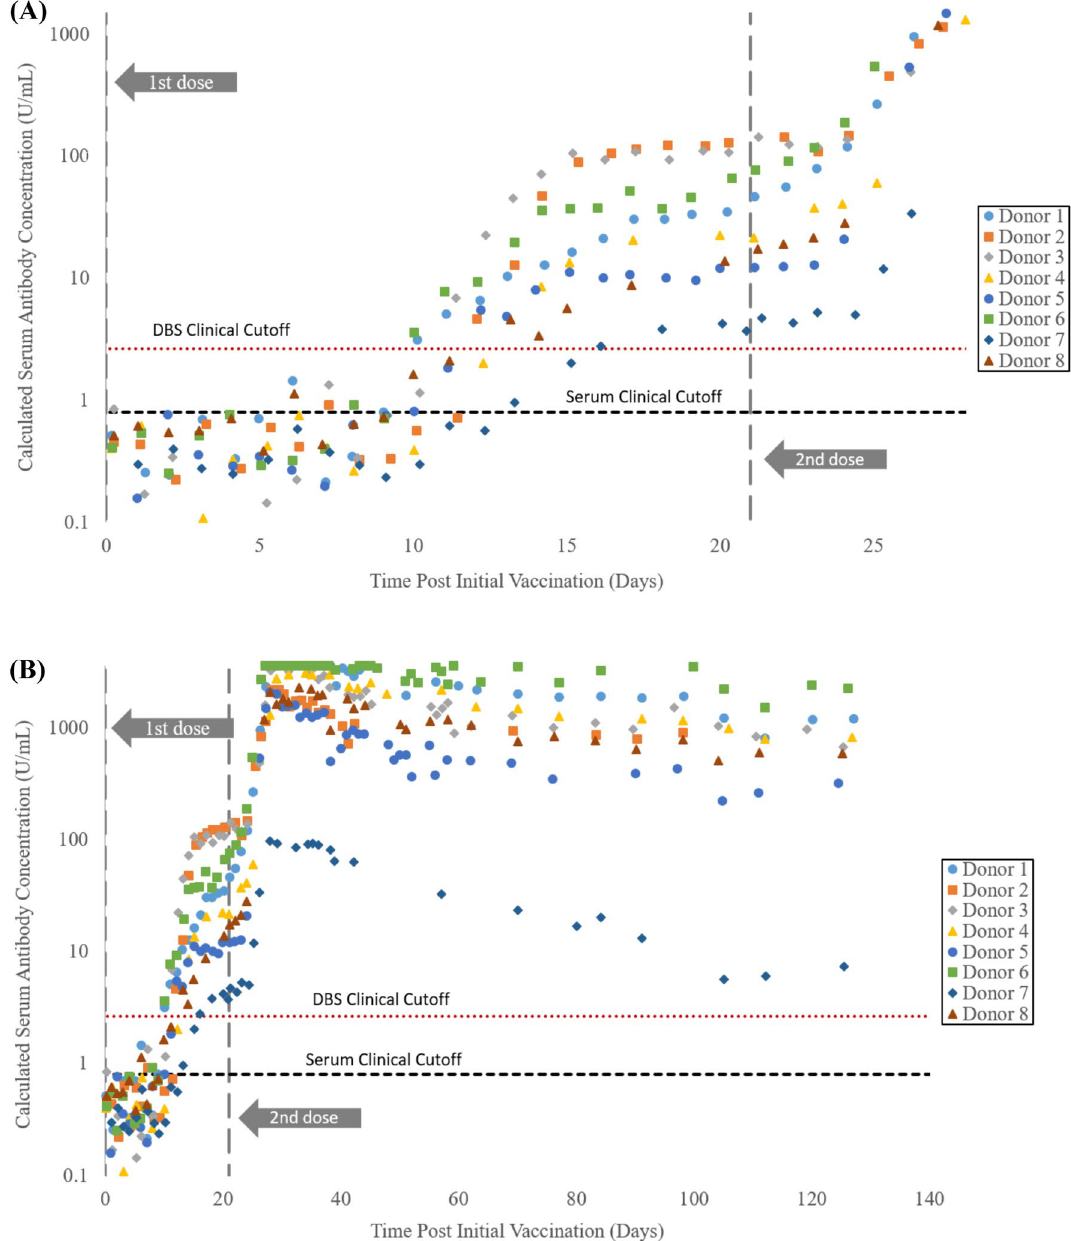
Figure 3. SARS-CoV-2 antibody levels measured from DBS samples following ( A ) pre-dose (Day 0) through receipt of second vaccine dose (Day 21) to day 28 and ( B ) through Day 132. Y-axes are displayed logarithmically with the left axis representing calculated serum levels (by dividing DBS results by